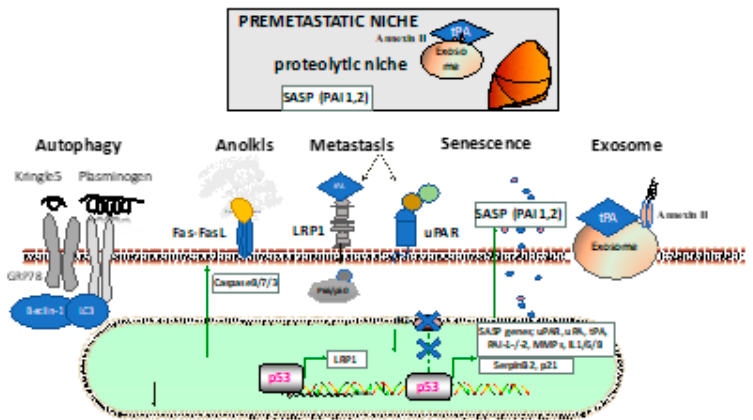
Figure 2. Establishment and interactions in the (pre)metastatic niche. The lower portion describes the mechanism through which fibrinolytic factors are involved in the cancer cells: autophagy through the Kringle 5 fragment or plasminogen; anoikis due to cell detachment with activation of the extrinsic apoptotic pathway through plasmin cleavage of the Fas ligand by plasmin; metastasis through pericellular plasmin activation via low-density lipoprotein receptor-related protein (LRP1) or uPA receptor (uPAR), alone or in complex with other membrane molecules (such as integrins or galectins); the participation of the senescence-associated secretory phenotype (SASP), including fibrinolytic factors like PAI-1 or PAI-2; the generation of fibrinolytic factor carrying exosomes that ensure the priming of the premetastatic niche in distant organs (such as the lung) with the establishment of the proteolytic niche. GRP78: glucose-regulated protein 78, LC3: microtubule-associated